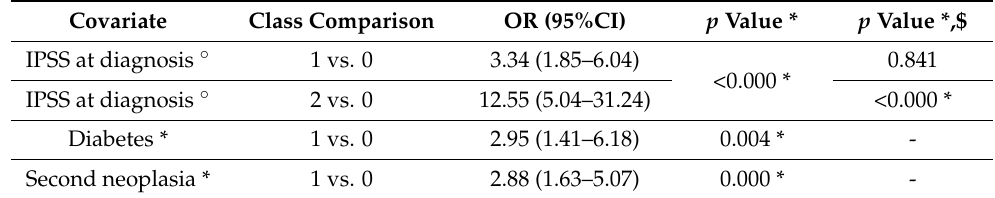
Table 4. Multivariable analysis considering the association between covariates and patients’ outcome (occurrence of death). Number of patients analysed: